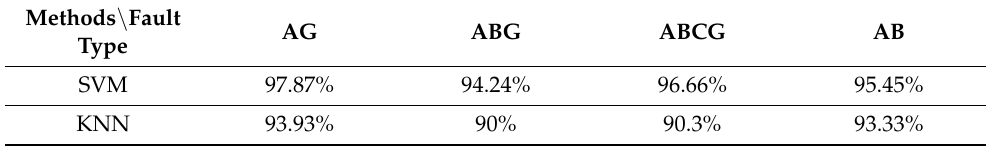
Table 3. The accuracy of SVM and KNN against different fault